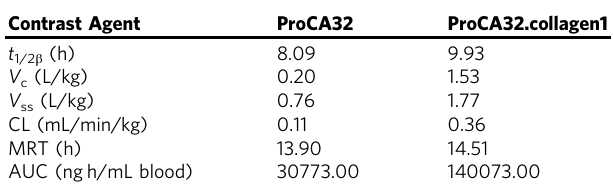
Table 3 Summary of pharmacokinetic parameters in mouse for ProCA32.collagen1 and ProCA32 Contrast Agent ProCA32